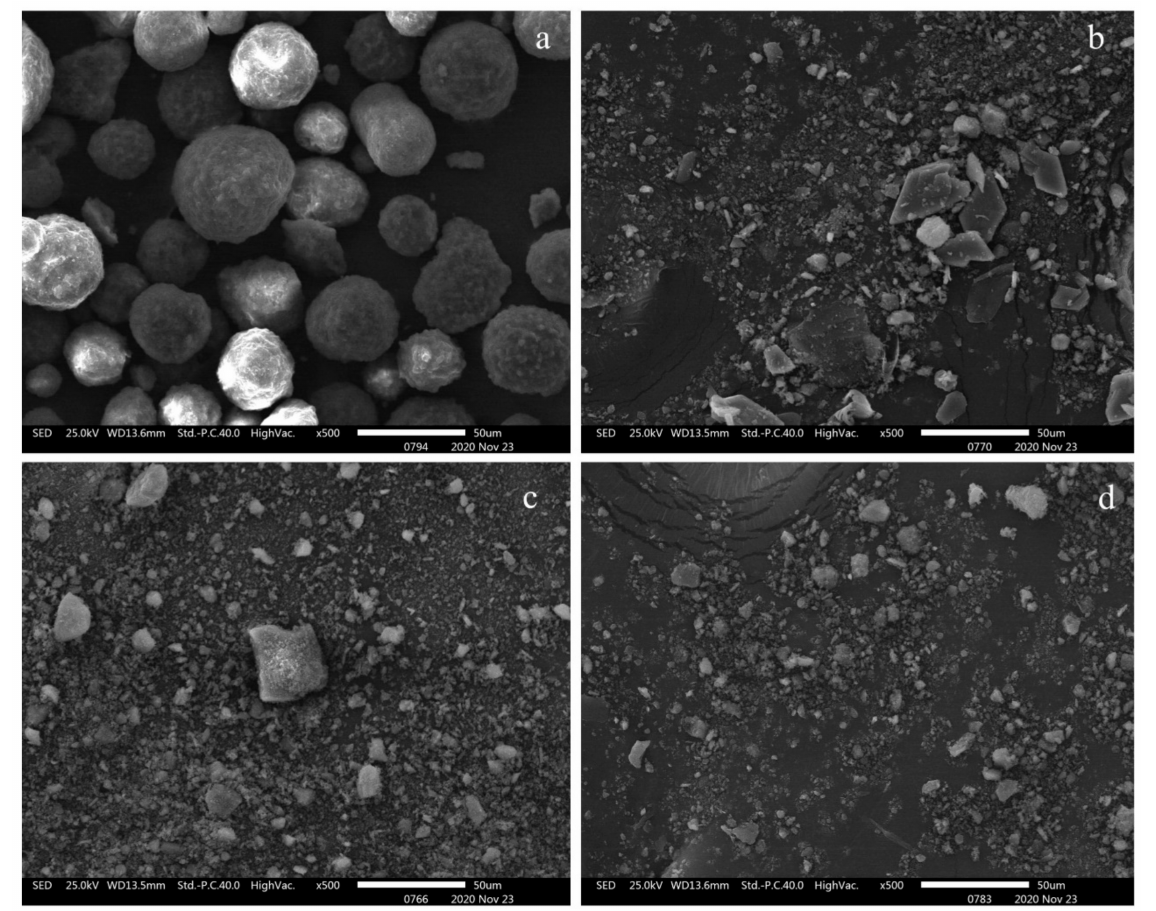
Figure 11. SEM images of the spent catalyst and various leaching residues: (( a ) SFCC catalyst; ( b ) leaching residue by C 2 H 2 O 4 ; ( c ) leaching residue by C 2 H 2 O 4 + H 2 O 2 ; ( d ) leaching residue by C 2 H 2 O 4 + H 2 O 2 with microwave-assisted process).